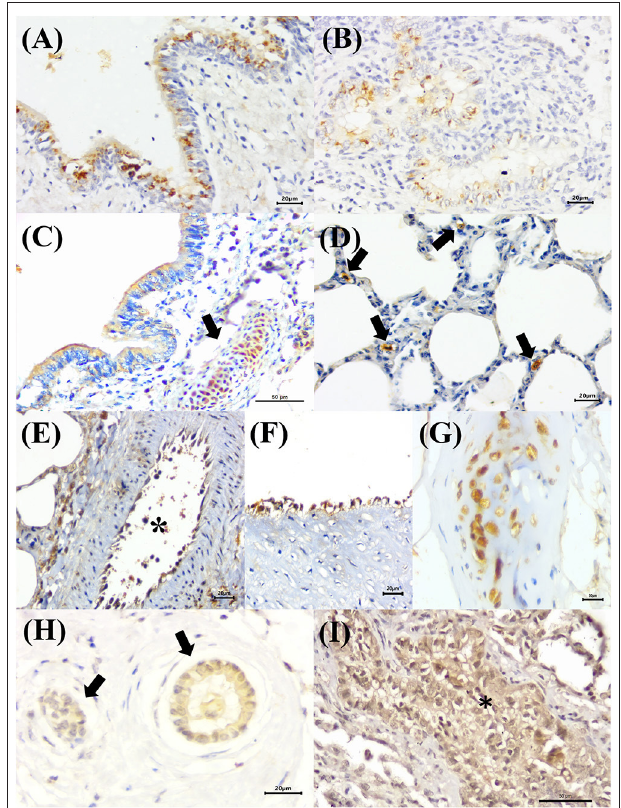
FIGURE 5 | Immunohistochemical demonstration of immunoreactivity to MCFV in cattle with bovine respiratory disease. There is positive intracytoplasmic immunoreactivity to antigens of MCFV within the cytoplasm of epithelial cells of the (A,B) terminal bronchiole and the patchy immunoreactivity within (C) alveolar epithelium (arrows) in a case of interstitial pneumonia. Observe intracytoplasmic immunoreactivity to antigens of MCFV within (D) degenerated bronchial epithelial cells, (E,F) chondrocytes of the hyaline cartilage (asterisk), (G) endothelium cells of a pulmonary venule (asterisk), macrophages (black arrows), lymphocytes (yellow arrow), and (H) epithelial cells of the mixed peribronchial glands. Immunoperoxidase counterstained with hematoxylin. Bar: (A,H) 100 µ m; (B–F) 50 µ m; and (G) 20 µ m.